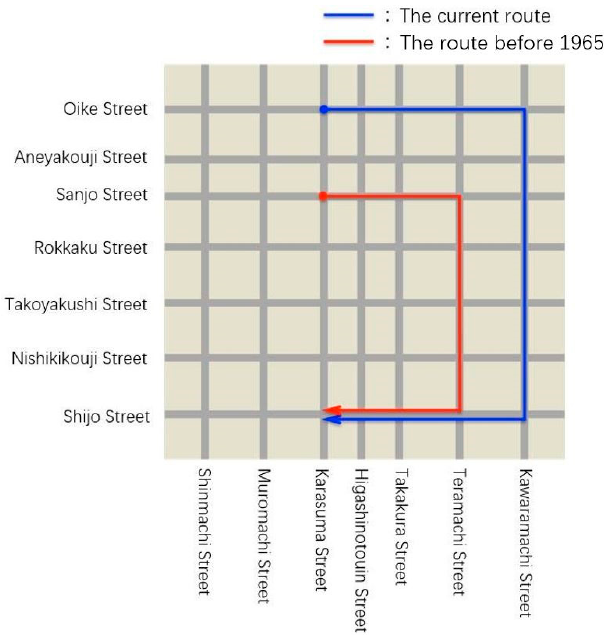
Figure 2. The current route and the original route of the atomatsuri procession of the festival floats in the Gion Festival.